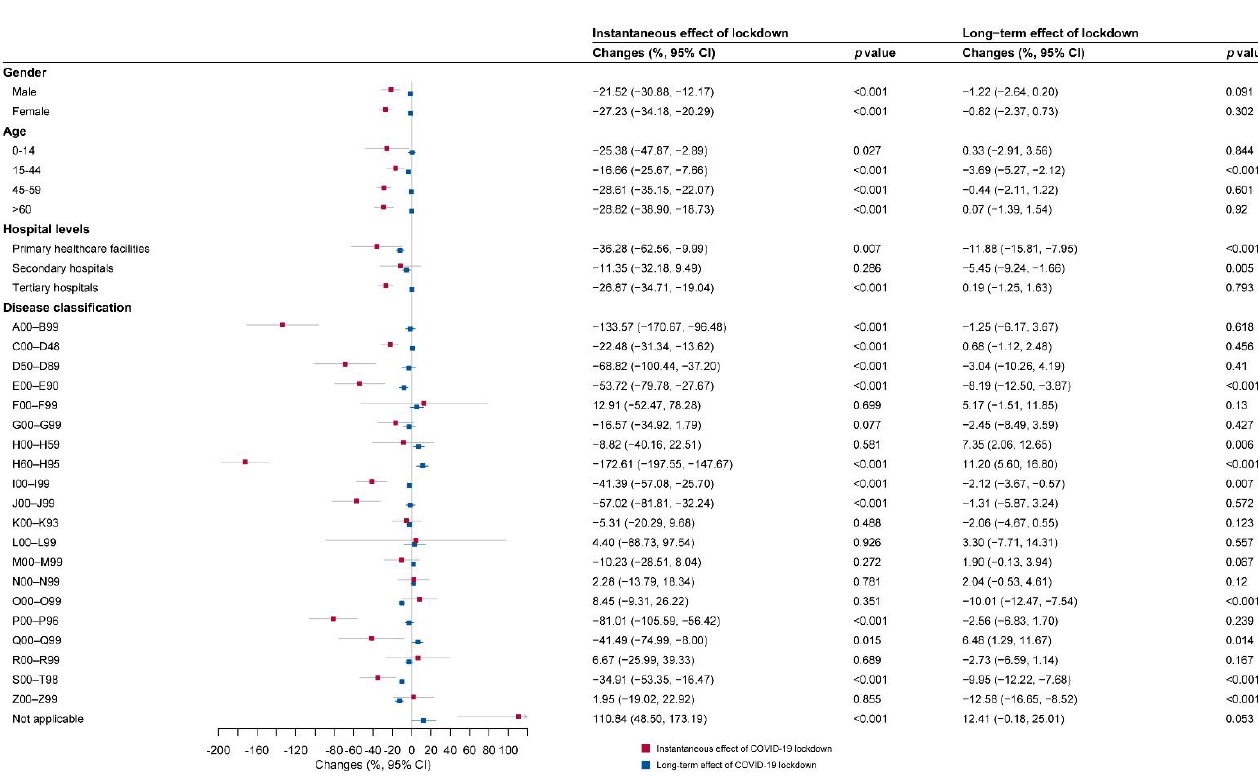
Figure 7. The instantaneous and long-term effect of COVID-19 lockdown on hospital visits